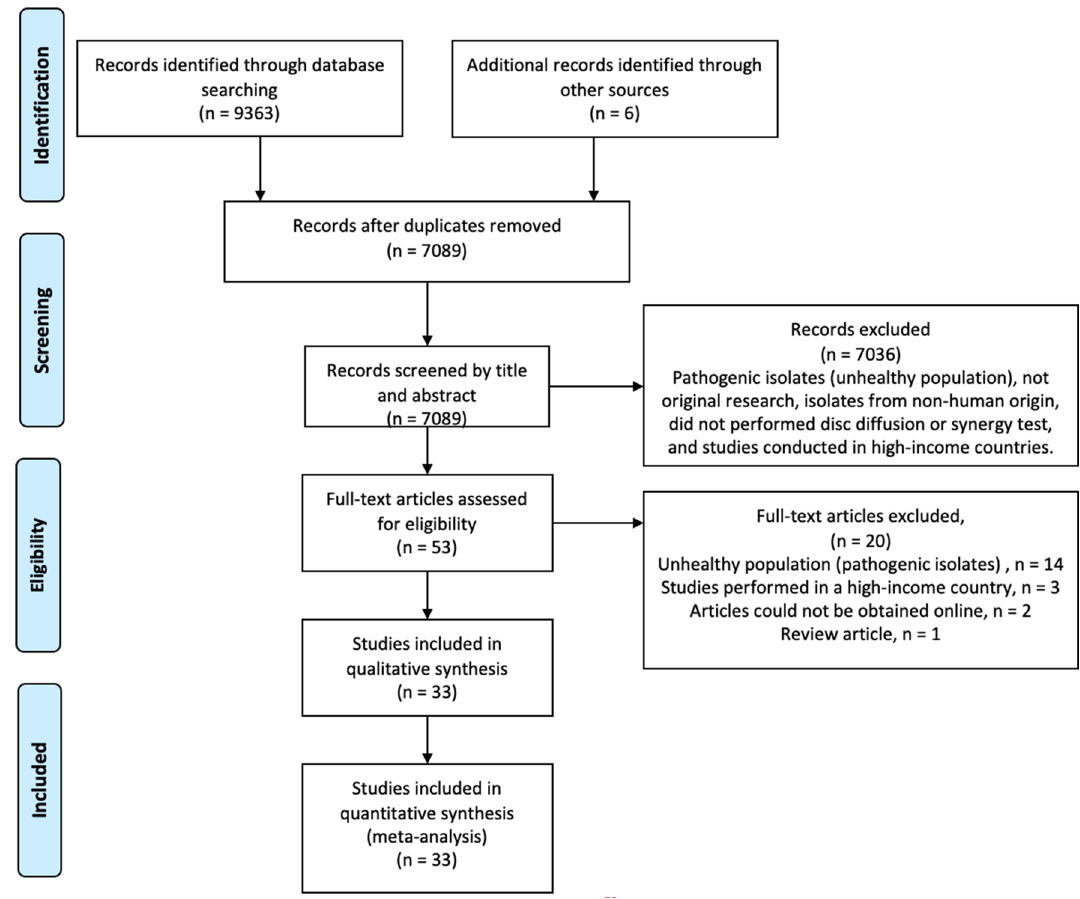
Figure 2. Flow diagram of the literature search strategy 73 . Additional records were identified from the reference lists of some of the included